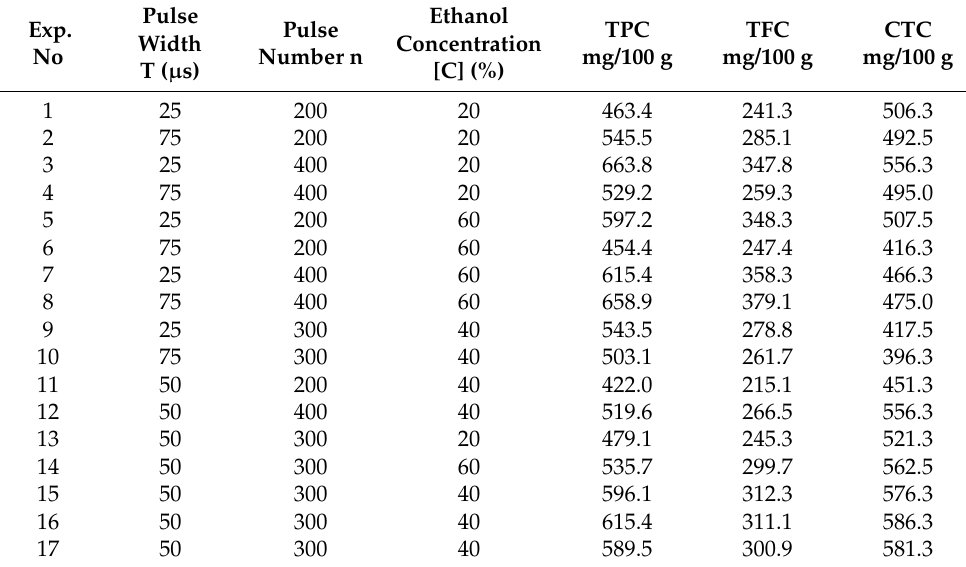
Table 1. Results of the CCF design